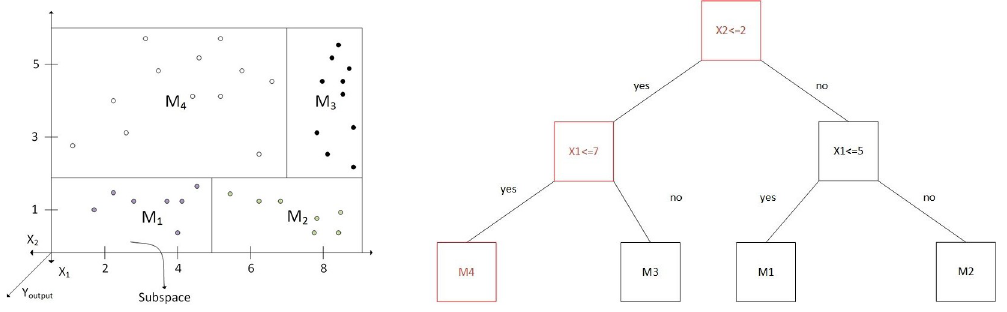
Fig 1. Schematic for the M5P